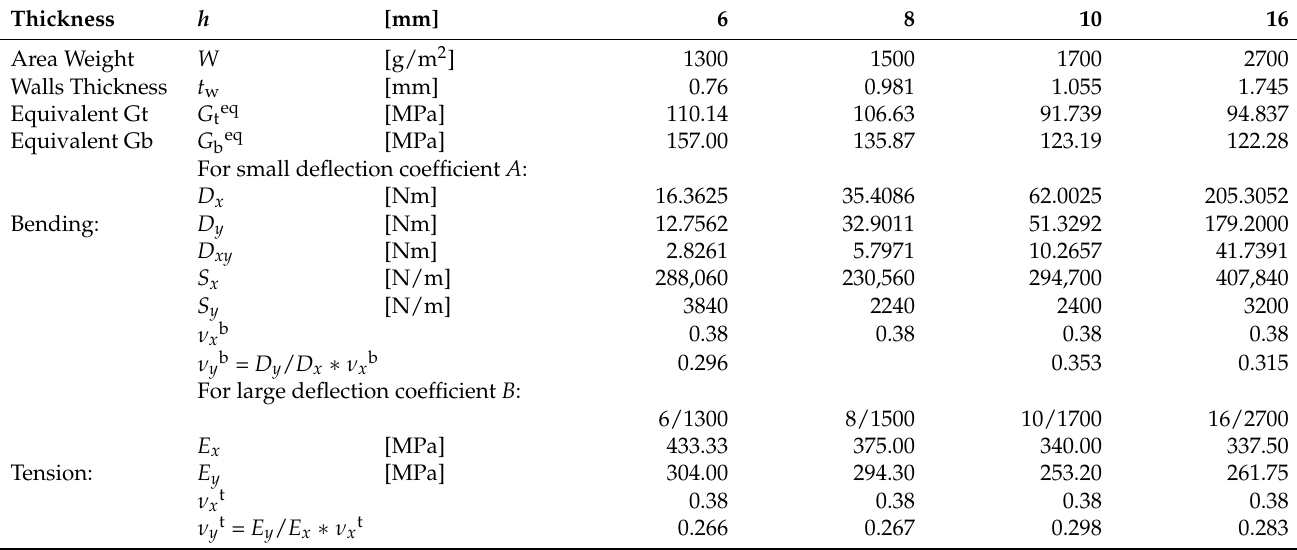
Table A3. Properties of plates used in the